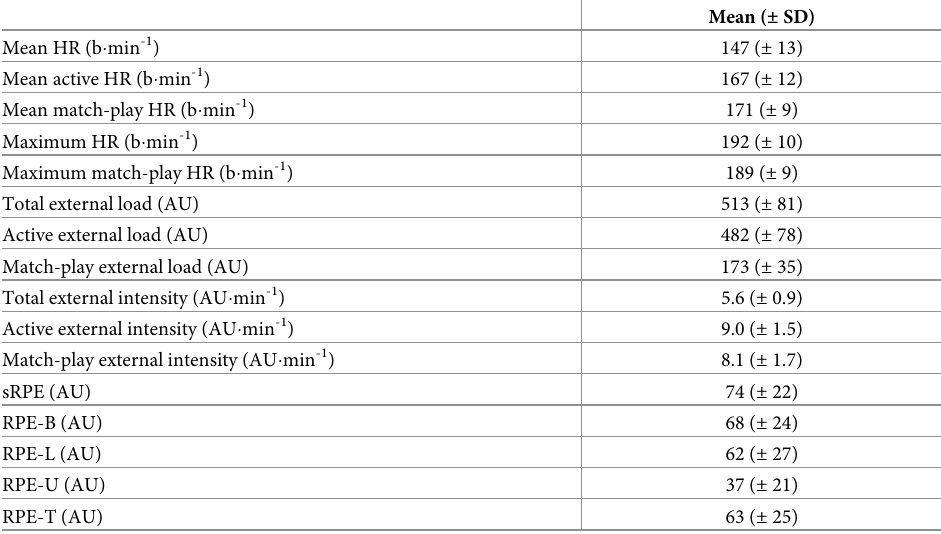
Table 1. Mean ( ± SD) of average HR, maximum HR, external load and external load intensity of the entire train- ing session, the active and the match-play portions, and sRPE and dRPE for the entire netball training